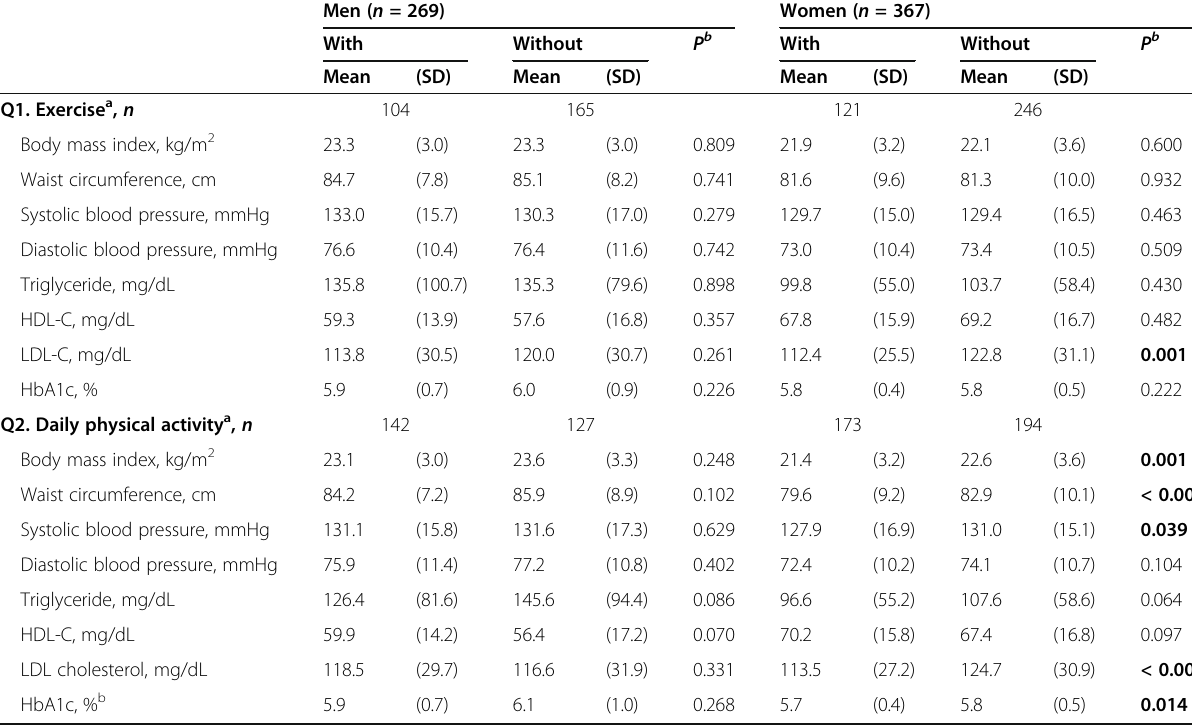
Table 4 Mean values of risk factors for metabolic syndrome in analyses stratified by sex and physical